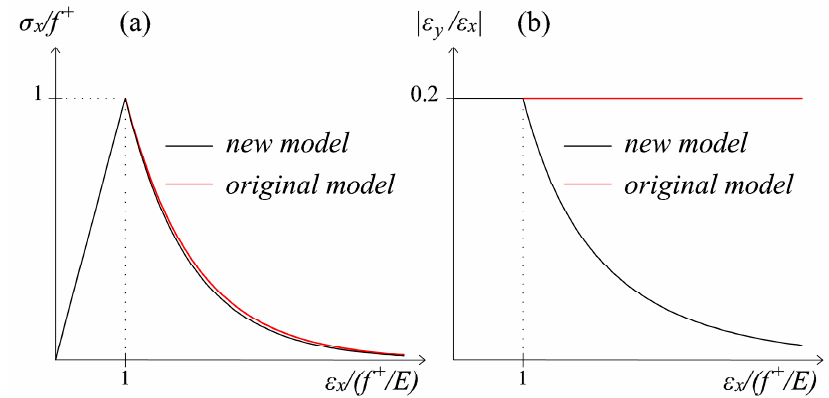
Figure 6. Comparison between the original formulation and the new energy-equivalent model for the problem of a bar uniaxially loaded in tension: ( a ) σ x - ε x curves and ( b ) the nominal Poisson’s ratio trends.